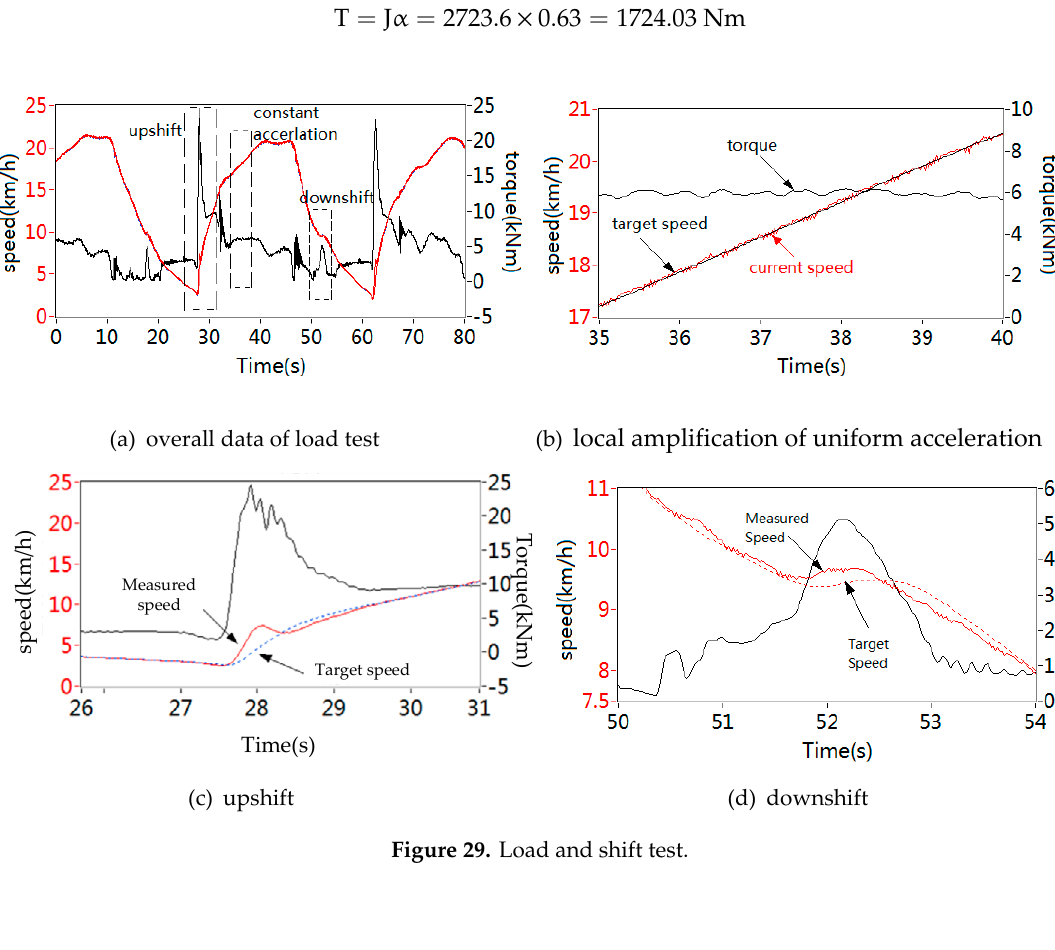
Figure 28. Comparison of results before and after correction. Table 1. Comparison of results before and after correction.